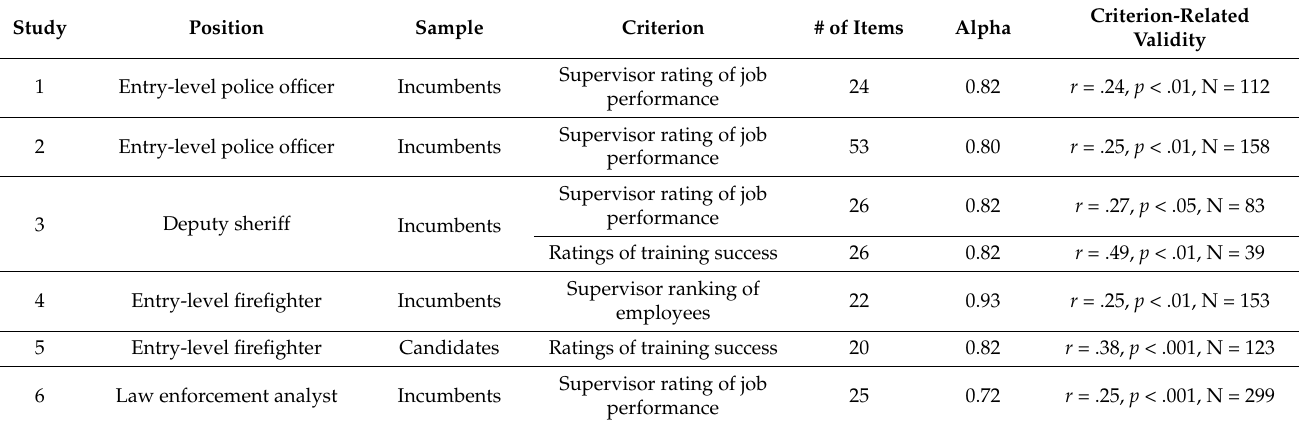
Table 1. Criterion-related validity in public safety jobs.